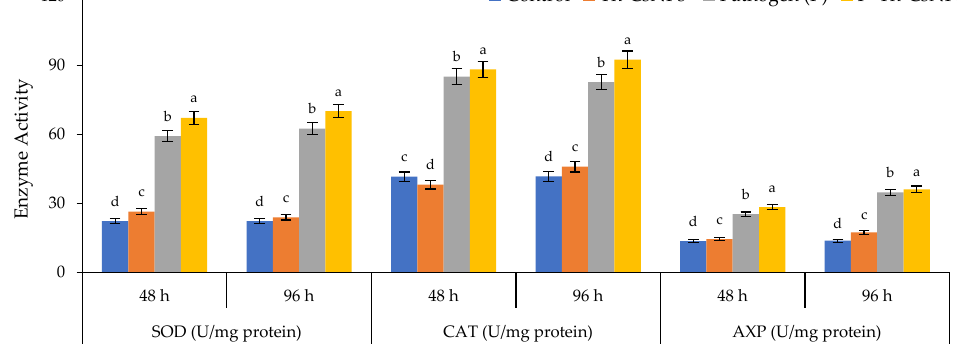
Figure 6. Effects of ThE-CsNPs on SOD, CAT, and AXP enzyme activity in S. lycopersicum seedling under fusarium root rot disease infection. Bars with different letters indicate significant differences between treatments at p ≤ 0.05. Data are expressed as mean values of three replicates ( ±